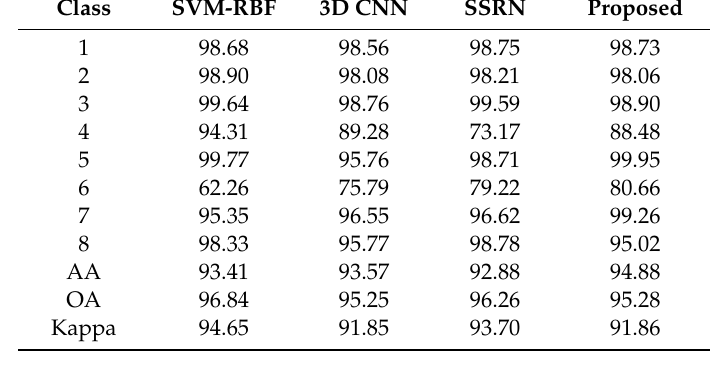
Table 6. Classification results (%) of different methods with 100% training samples.